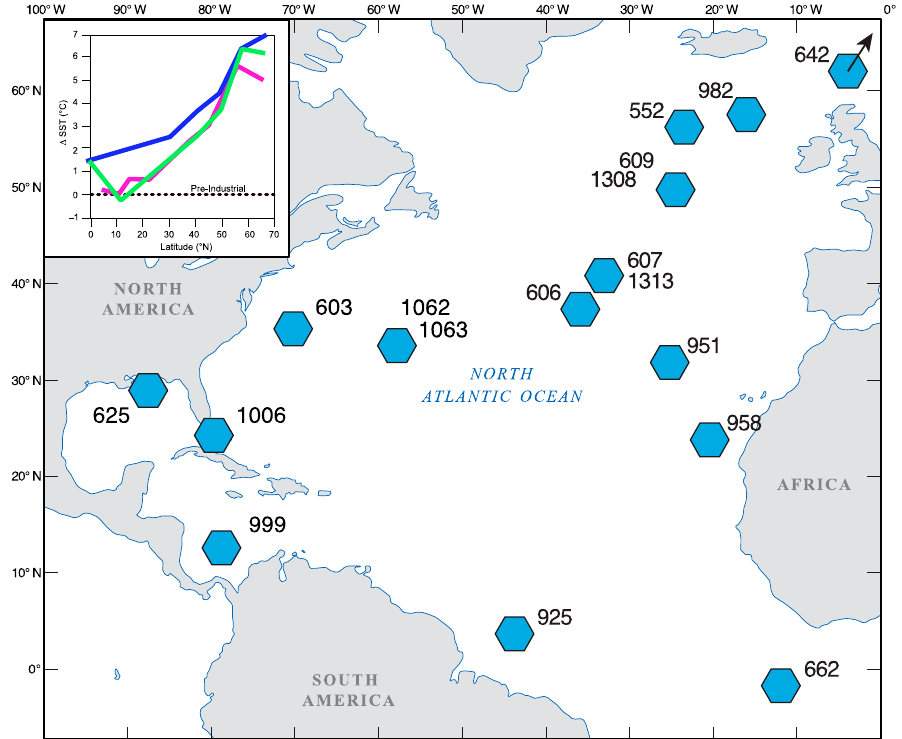
Figure 1. Map of Pliocene core sites. Geographic location of 18 North Atlantic sites used in this study. Inset figure shows North Atlantic temperature gradients as anomalies from the pre-industrial gradient (horizontal black dashed line). Multiproxy gradient from Dowsett et al. [41], pink; PRISM4 alkenone-based gradient from Dowsett et al. [42], green; PlioVAR (Pliocene Climate Variability over glacial–interglacial timescales) gradient based on alkenone SST estimates from McClymont et al. [43], blue. PRISM4 and PlioVAR gradients are based upon alkenone analyses calibrated to Müller et al. [44] .